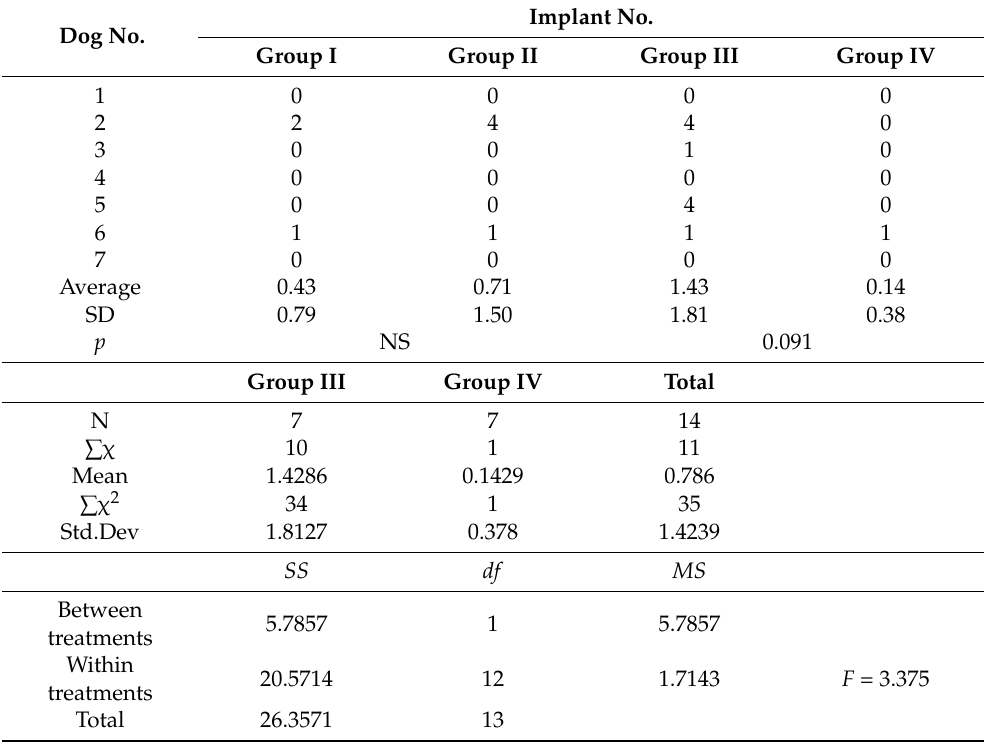
Table 2. Scoring according to Tal soft tissue classification [20–23]. Dog No.